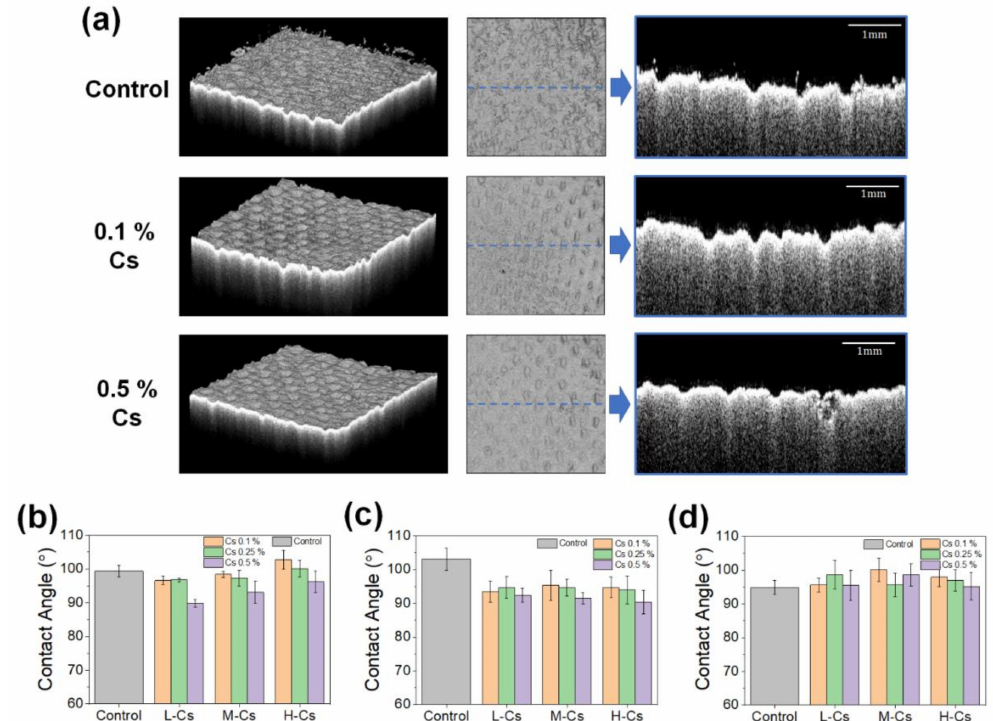
Figure 10. ( a ) OCT imaging of the surface of seaweed paper (High S%) coated with varying chitosan concentrations; 0% (control), 0.1% and 0.5%. Three-dimensional and cross-sectional (along the dotted line) views are presented. Water contact angles measured on chitosan-coated papers: ( b ) Low S% seaweed paper, ( c ) High S% seaweed paper and ( d ) plant paper. Uncoated papers were used as